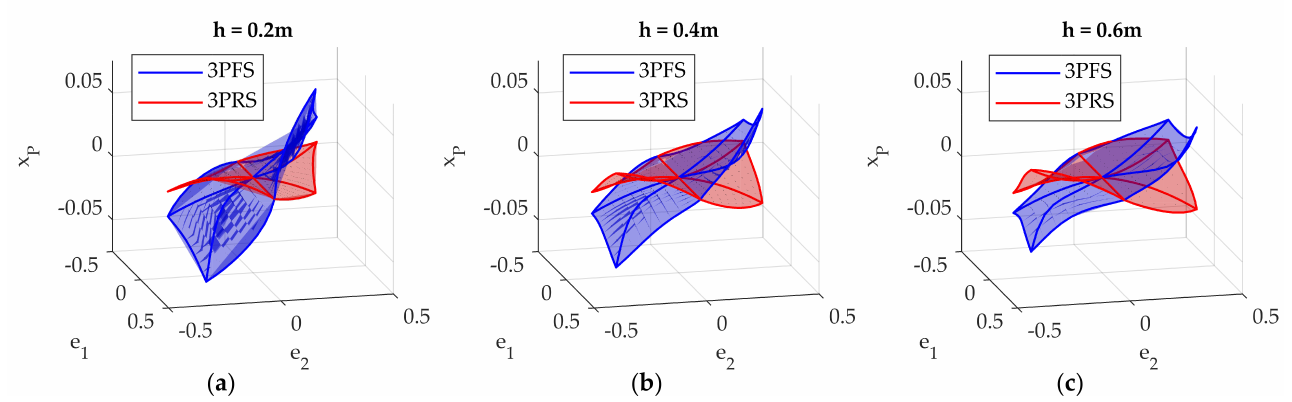
Figure 12. Parasitic motion x P